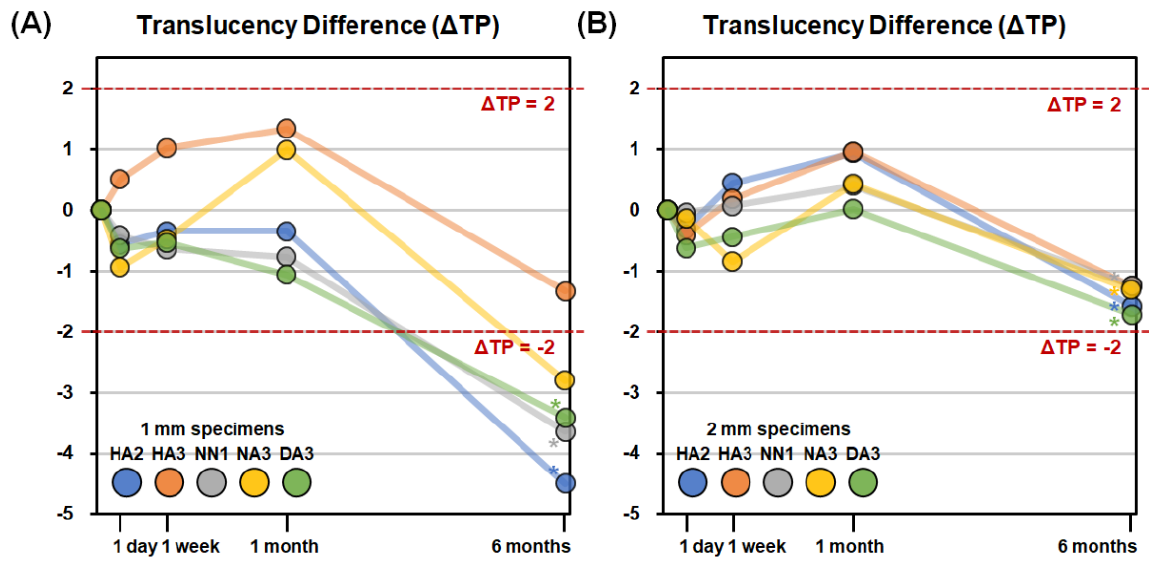
Figure 5. Mean translucency differences ( ∆ TP) of the specimens after different storage periods compared to the 1 h translucency measurements. ( A ) 1 mm specimens. ( B ) 2 mm specimens. Asterisk (*) indicates a statistically significant difference of TP value compared to the 1 h